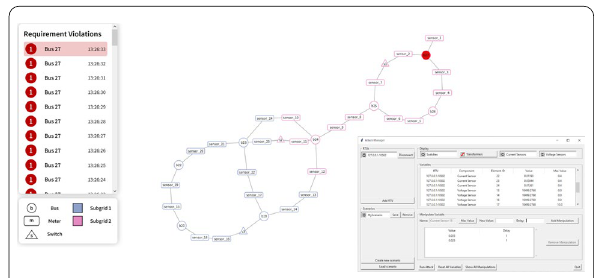
Fig. 2 User interface of the implemented IDS (left), supervising the testbed and the attack tool